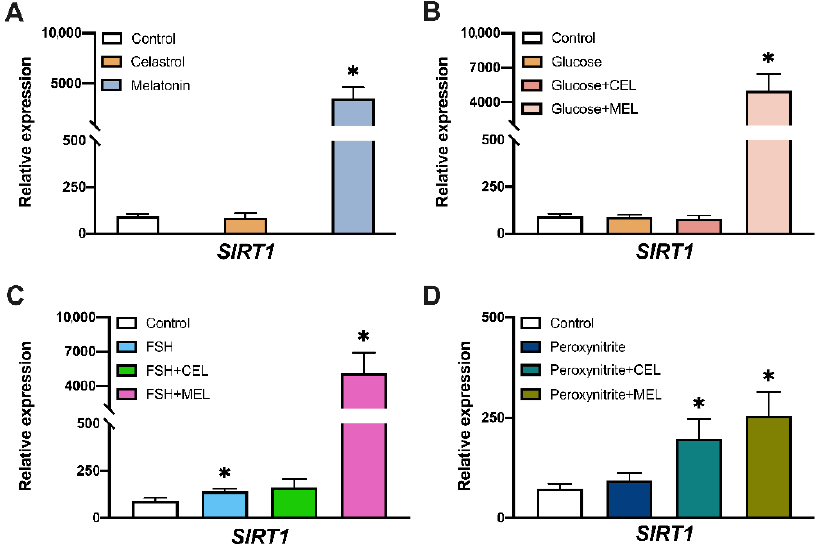
Figure 3. Effect of glucose, peroxynitrite, FSH, celastrol (CEL), melatonin (MEL) and their combi- nations on SIRT1 gene expression. SIRT1 relative expression levels in hGL cells treated with: ( A ) celastrol ( n = 19) or melatonin ( n = 18), ( B ) glucose ( n = 17) and in combination with celastrol ( n = 19) or melatonin ( n = 18), ( C ) FSH ( n = 17) and in combination with celastrol ( n = 19) or melatonin ( n = 18), ( D ) peroxynitrite ( n = 20) and in combination with celastrol ( n = 18) or melatonin ( n = 17). Asterisks (*) indicate statistically significant differences compared to control.